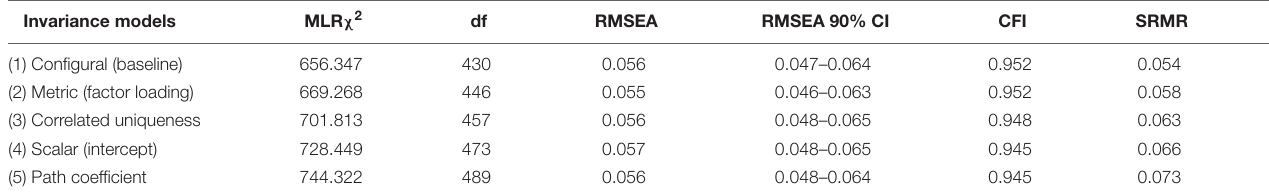
TABLE 2 | Tests for gender invariance: summary of goodness-of-fit statistics. Invariance